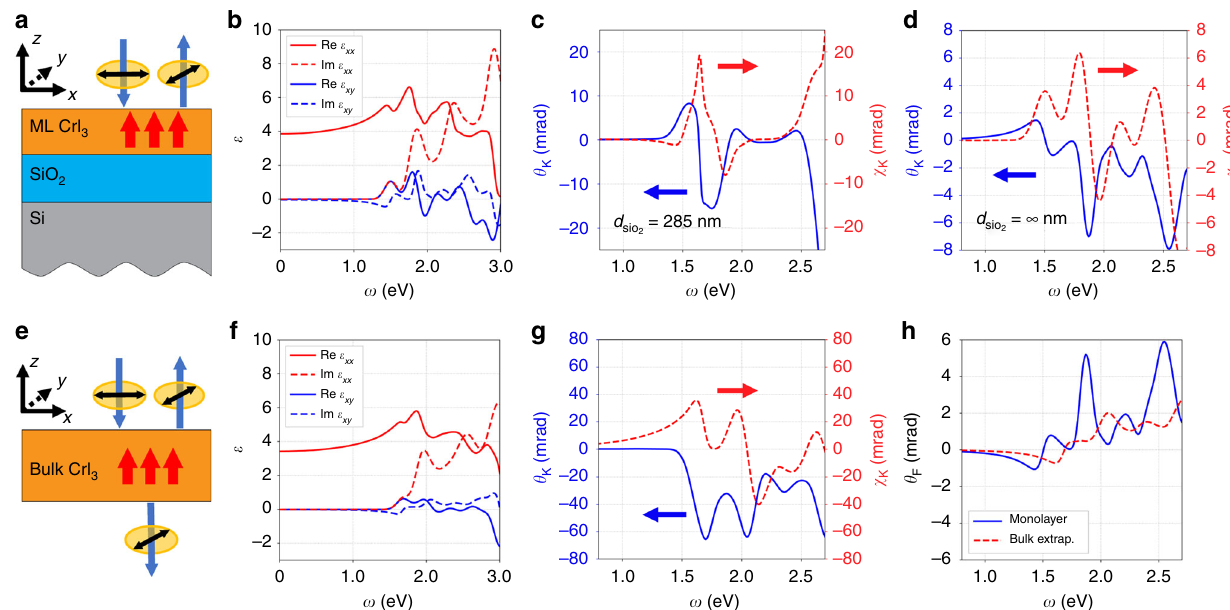
Fig. 4 MO signals calculated from fi rst-principles dielectric functions. a P-MOKE setup consisting of layers of vacuum, ferromagnetic monolayer CrI 3 , SiO 2 fi lm, and semi-in fi nitely thick Si. Red arrows denote the out-of-plane magnetization, which is pointing along the + z direction. Blue arrows denote the propagation direction of light, and black double-headed arrows give the corresponding linear polarization direction. Each orange ellipse denotes a polarization plane of the electric fi eld of light. b Calculated real part (solid lines) and imaginary part (dashed lines) of both the diagonal ε xx (red) and off- diagonal ε xy (blue) dielectric functions of ferromagnetic monolayer CrI 3 , using a monolayer thickness d = 6.6 Å. An 80 meV energy broadening is applied. c Kerr angle θ K (left, blue solid) and Kerr ellipticity χ K (right, red dashed) for the P-MOKE setup with a 285 nm SiO 2 layer. d Kerr angle θ K (left, blue solid) and Kerr ellipticity χ K (right, red dashed) for the P-MOKE setup in ( a ) with semi-in fi nitely thick SiO 2 layer. e P-MOKE and P-FE setup of a suspended ferromagnetic bulk CrI 3 layer with the directions of light propagation and magnetization similar to ( a ). f Calculated real part (solid lines) and imaginary part (dashed lines) of both the diagonal ε xx (red) and off-diagonal ε xy (blue) dielectric functions of ferromagnetic bulk CrI 3 , with an 80 meV energy broadening. g Kerr angle θ K (left, blue solid) and Kerr ellipticity χ K (right, red dashed) for the setup in ( e ) with in fi nitely thick ferromagnetic bulk CrI 3 . h Comparison between Faraday angle θ F of a suspended ferromagnetic monolayer CrI 3 and extrapolated bulk value down to the monolayer thickness (6.6